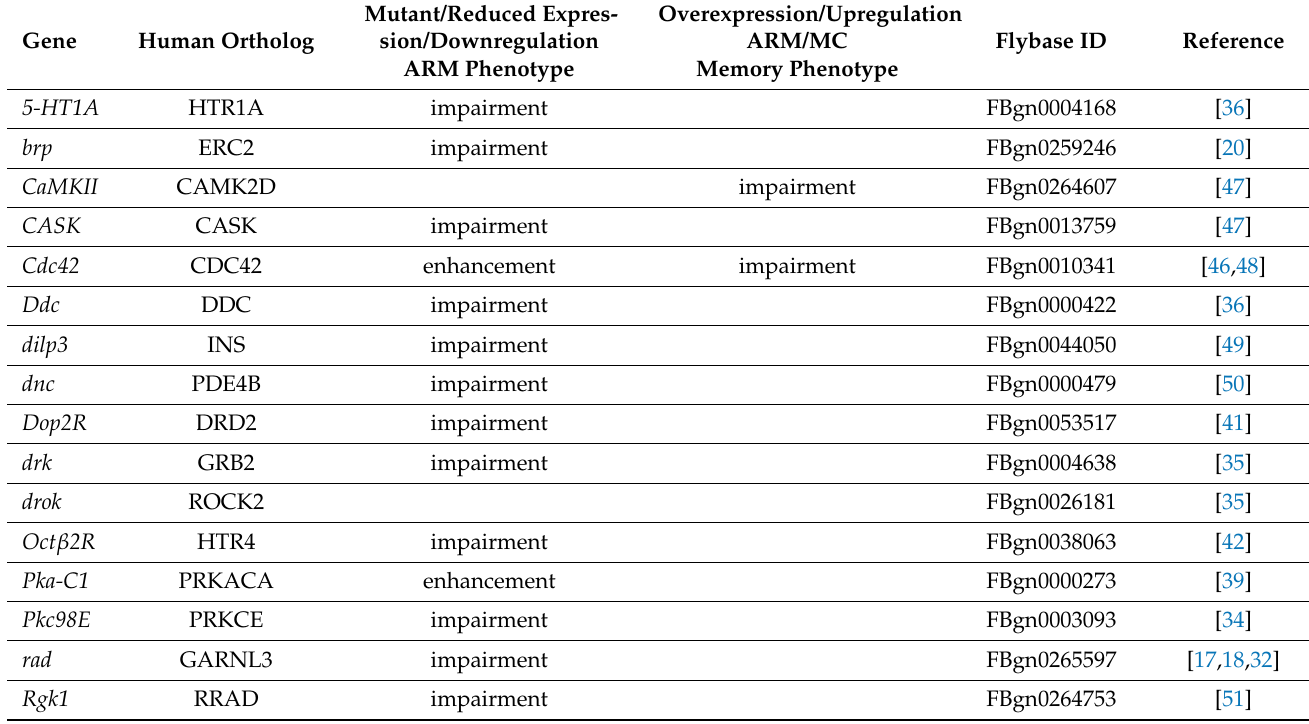
Table 2. Phenotypic outcome of altered expression of genes involved in